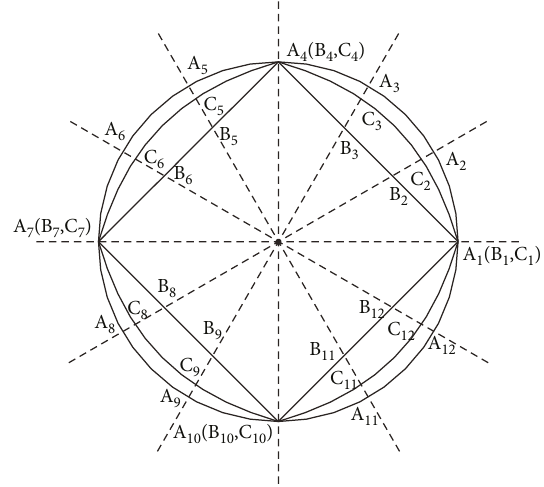
Figure 2: Illustration of the Ray fi ring algorithm.